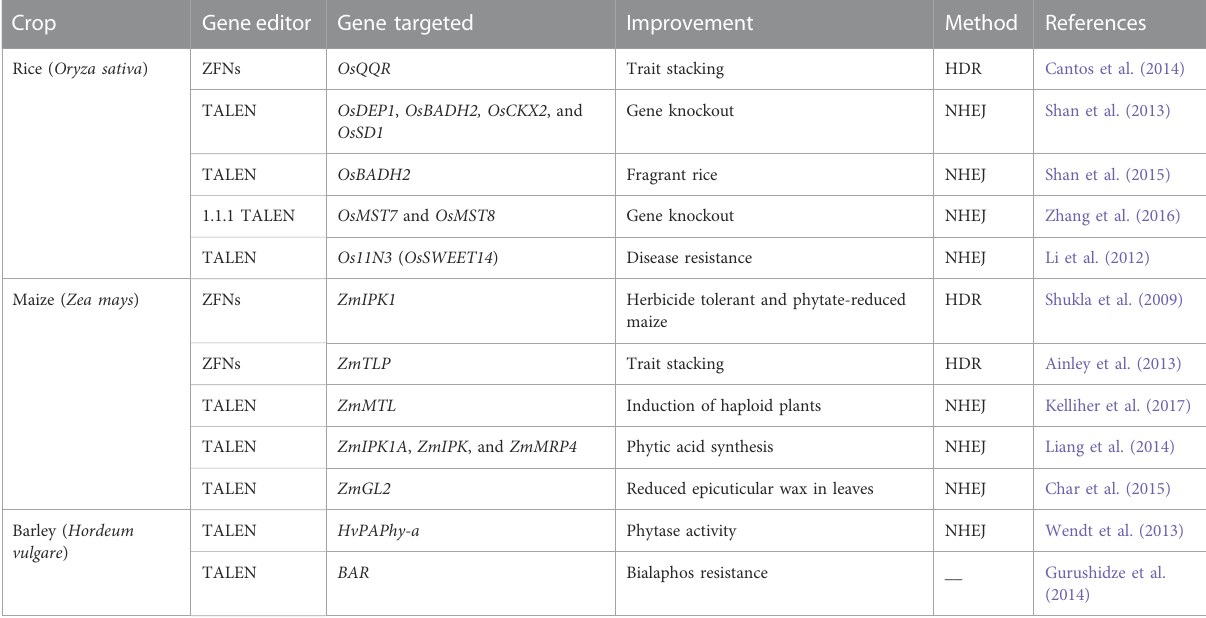
TABLE 1 ZFNs and TALENs for nutritional and phenotype improvement in